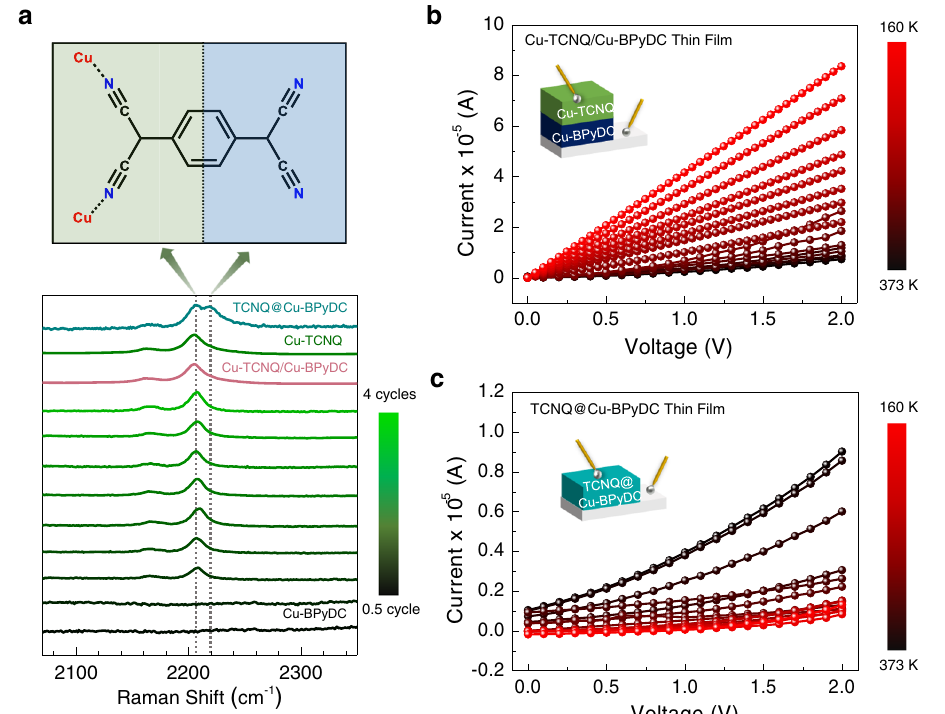
Fig. 5 | Eliminating the effect of molecular doping. a Raman spectra recorded during the growth of Cu-TCNQ on top of Cu-BPyDC thin fi lm (at each step of LbL and up to 4 cycles). Raman spectra of pristine Cu-TCNQ and TCNQ @Cu-BPyDC thin fi lms are also provided for a direct comparison. CN groups of TCNQ will have different vibrational signatures if coordinated to metal ion (like Cu in the present study) — asschematicallyshownandhighlightedbyblueandgreencolors.Positions